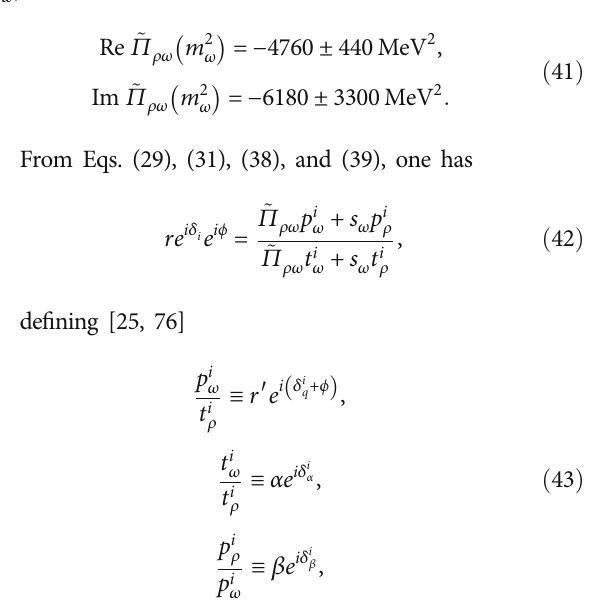
Figure 1: The diagram for the (cid:1) B 0 − ω mixing mechanism for the fi rst order of the isospin violation in the isospin